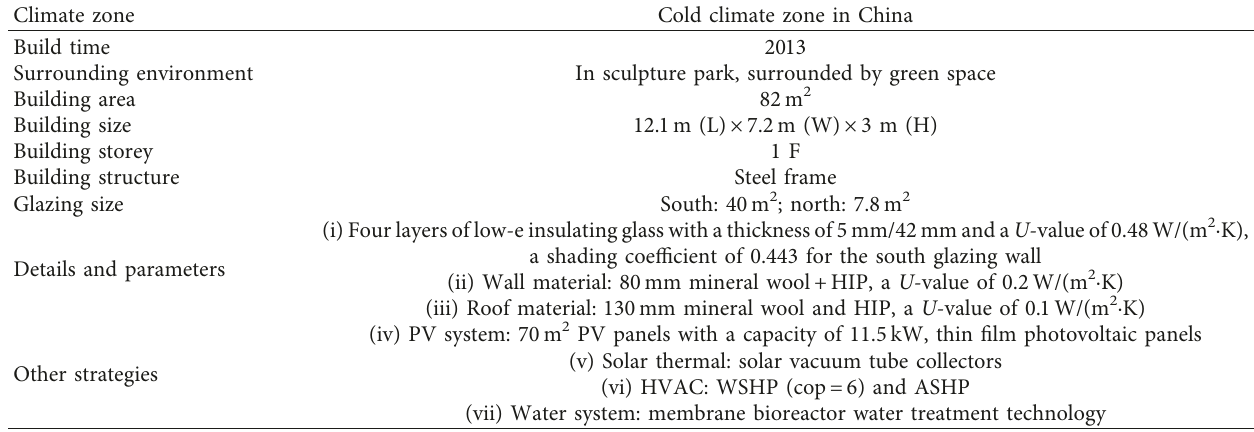
Table 3: Building